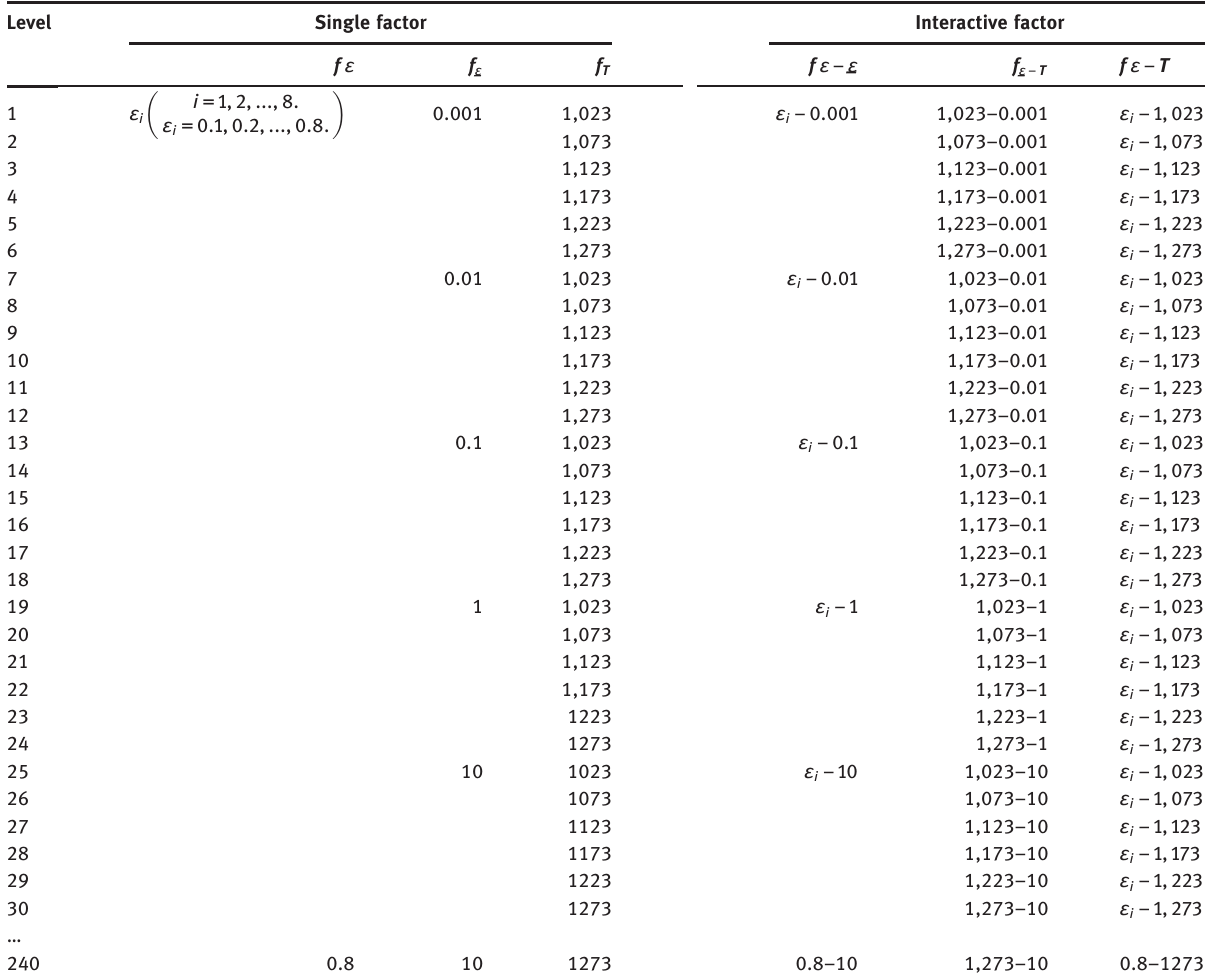
Table 1: List of factors of BFe10-1-2 cupronickel alloy. Level Single factor Interactive